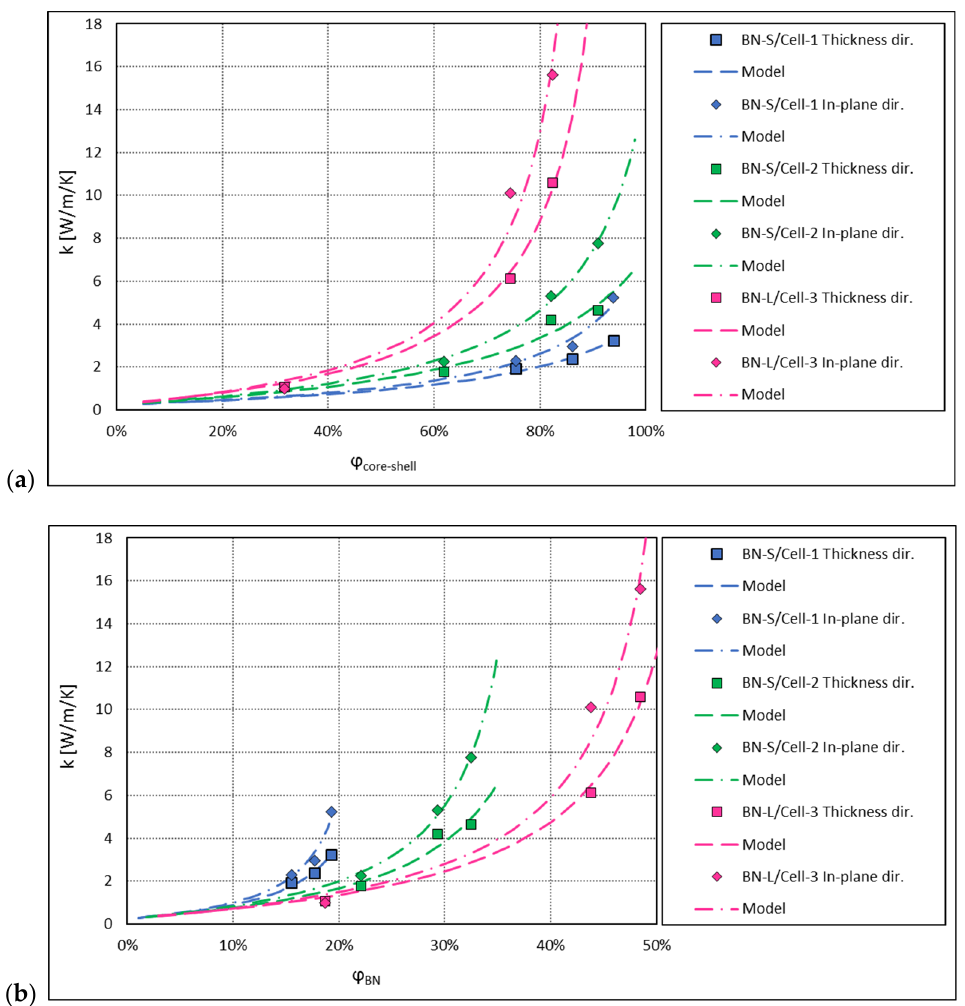
Figure 11. Thermal conductivity of composites with cellulose-BN core-shell fillers of Reference [19]. Lines show the results of model calculations, symbols are measured values: ( a ) Thermal conductivity vs. the core-shell filler volume content in the system, as calculated according to Equation (6). ( b ) Thermal conductivity vs. the absolute volume fraction of BN in the system, as originally presented in Reference [19].